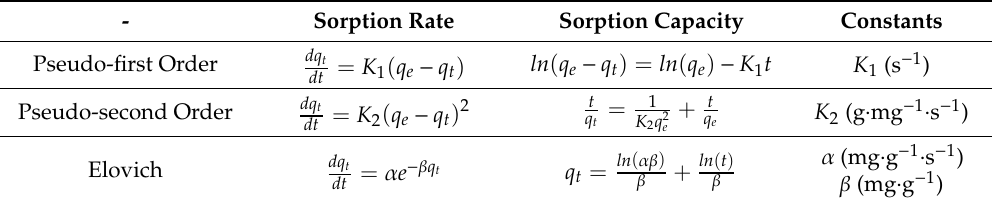
Table 3. Summary of formulas and parameters of the sorption kinetic models. - Sorption